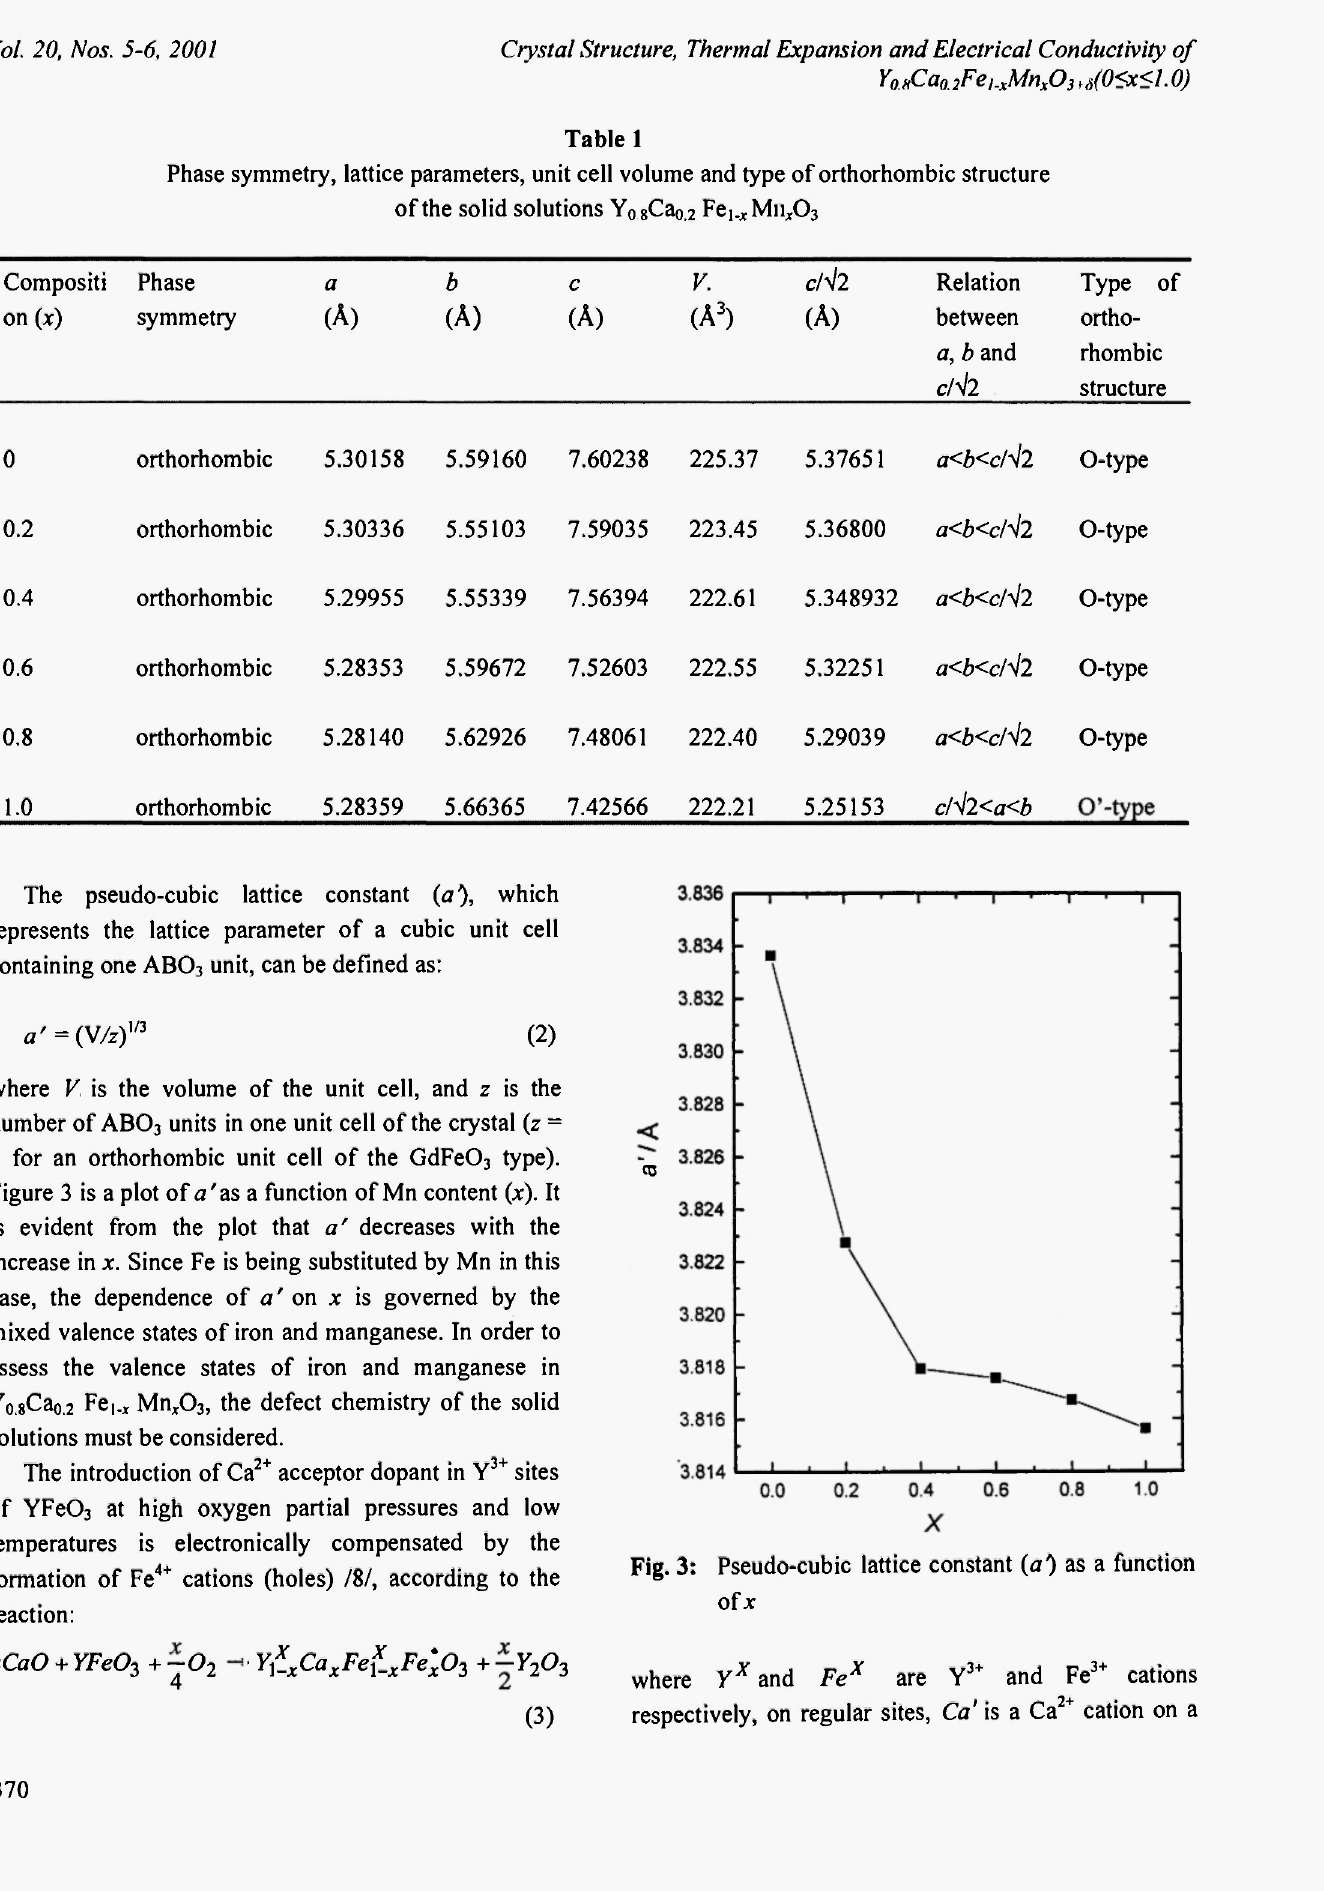
Phase symmetry, lattice parameters, unit cell volume and type of orthorhombic structure of the solid solutions YogCao.2 Fe^MiijOj